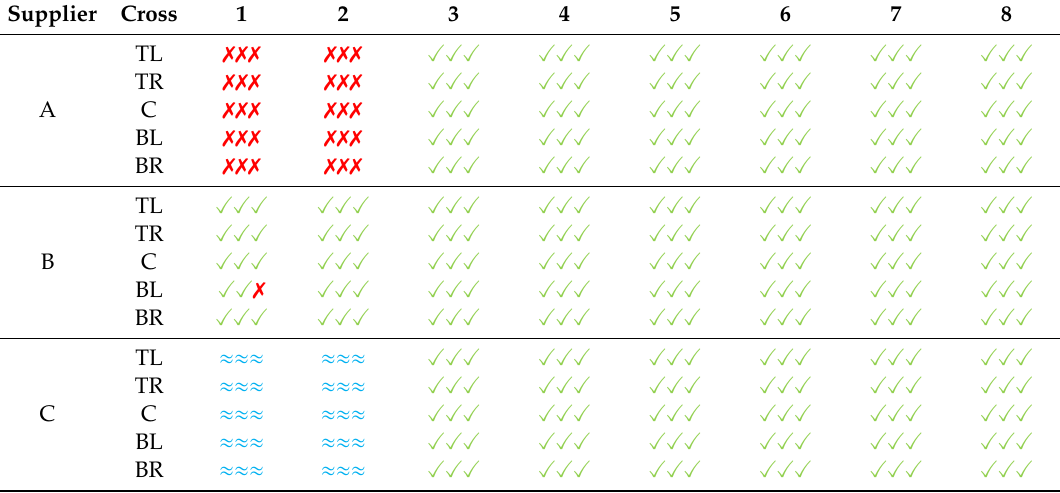
Table 8. Cross construction summary for each company. ✓ acceptable; ≈ existing feature, oversize; ✓ existing feature, not acceptable; (cid:55) not existing feature, not acceptable; ✗ not built.